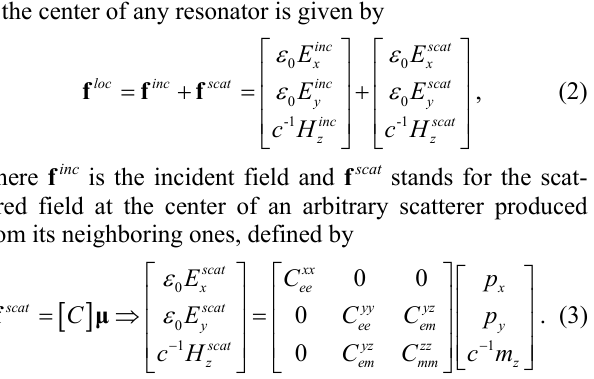
Figure 3: The second metasurface of bianisotropic scatterers at the y = 0 plane. The periods of the lattice along the x - and z -, direction are b and a , respectively. A TEM wave propagat- ing along the y -axis impinges normally on the